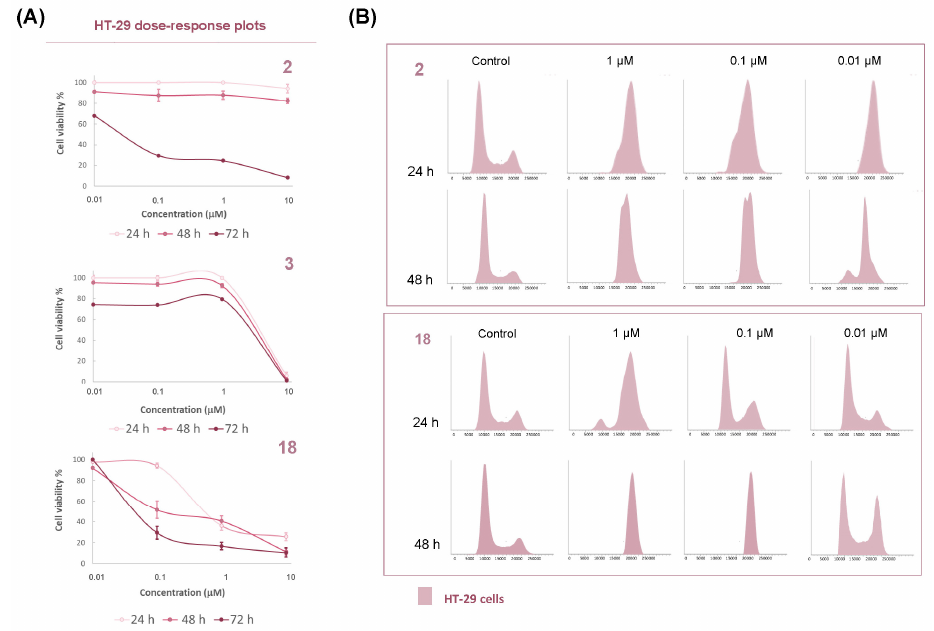
Figure 5. ( A ) Dose–response plots of the precursors 2 and 3 and the hybrid 18 at different times of incubation (24, 48, and 72 h) and concentrations (0.01–10 µM) in HT-29 cells. ( B ) Flow cytometry plots of the effect of 2 and 18 at different times of incubation (24 and 48 h) and concentrations (1–0.01 µM) in HT-29 cells.